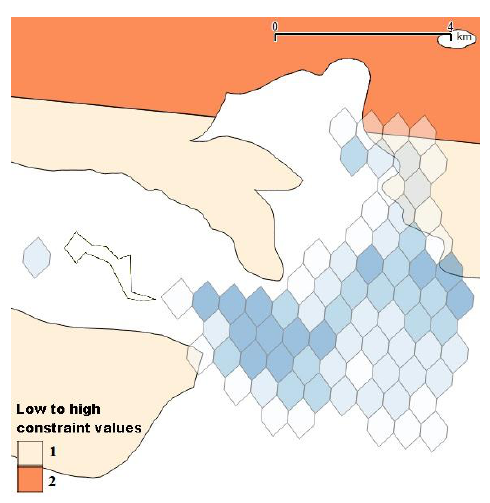
Figure 8. Net fishing